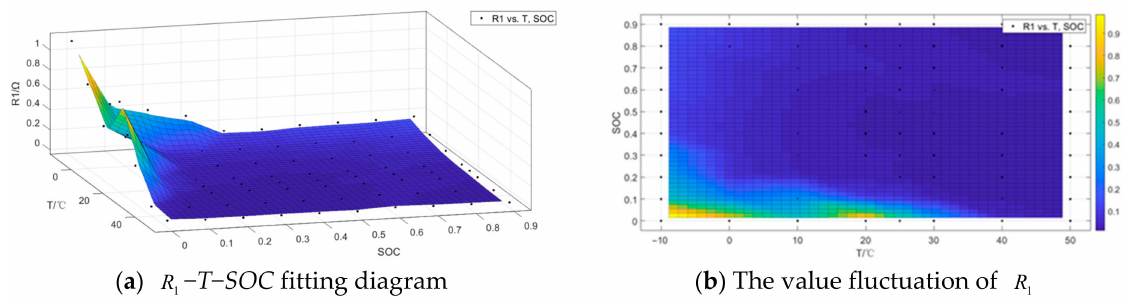
Figure 9. Variation of R 1 with temperature and SOC .